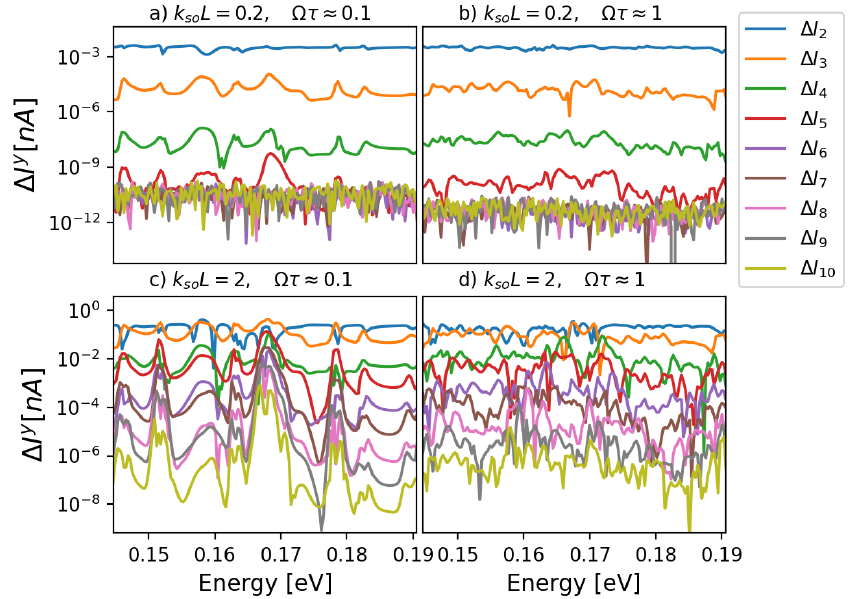
Figure 10: The convergence in n of the AC spin currents generated by the time- dependent Rashba SOI, where ∆ I with maximum Floquet states N . The parameters correspond to Ω τ ≈ 0.1 and 1, and k L = 0.2 and so